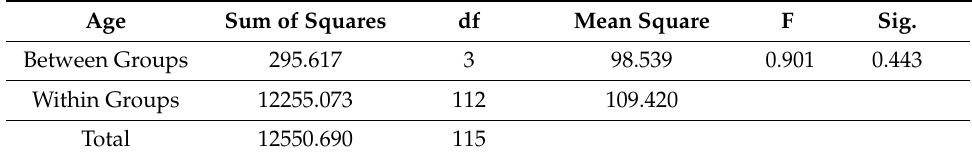
Table 6. ANOVA test for equality of mean ages.